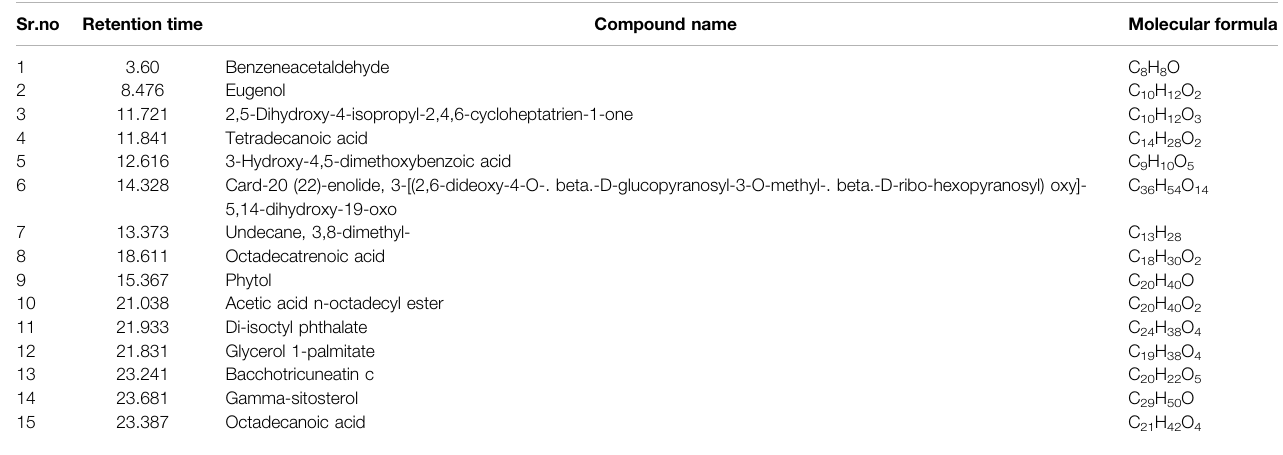
TABLE 1 | Phytochemical constituent analysis of Viola odorata methanolic extract by using the GC-MS